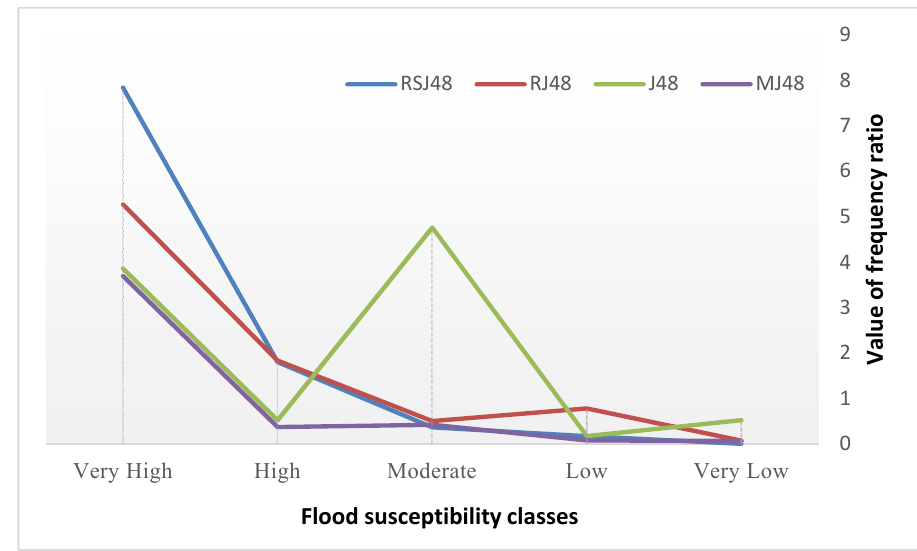
Figure 7. Receiver operating characteristic (ROC) curves representing the accuracy of the flood susceptibility models ( a ) training dataset (success rate curve), ( b ) validation dataset (prediction rate curve).